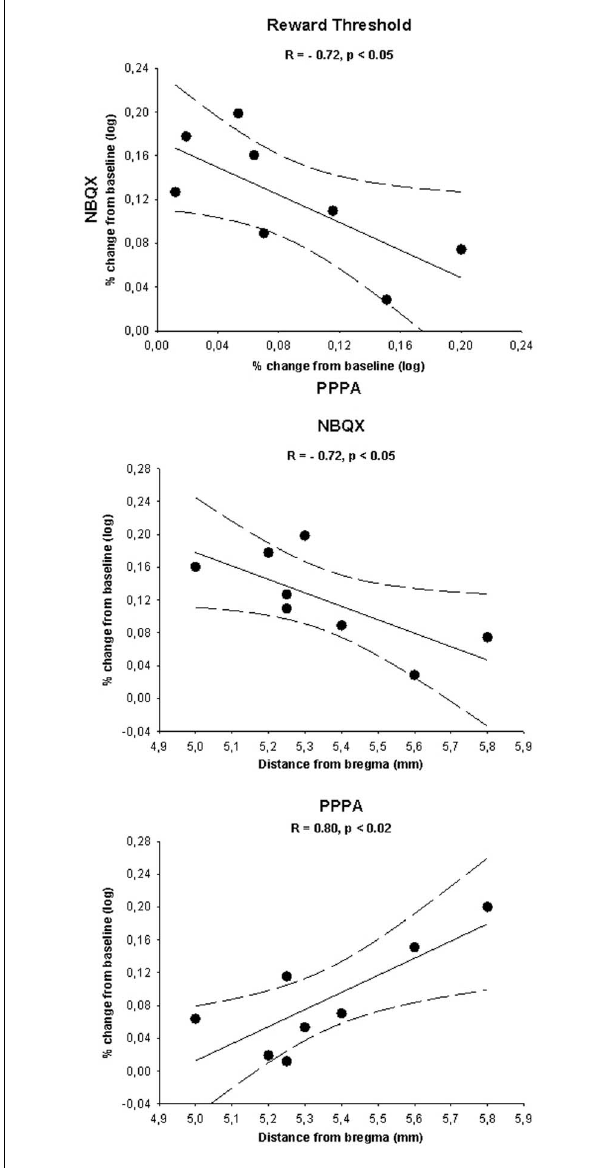
FIGURE 6 | The top panel shows a scatter plot illustrating the log percent change (from baseline) in reward threshold measured for each rat after injection of 0.825nmol of PPPA ( x -axis) and 800pmol of NBQX ( y -axis). Scatter plots illustrating the log percent change (from baseline) in reward threshold measured for each rat after injection of 0.825nmol of PPPA and 800pmol of NBQX as a function of the location of the injections sites along the antero-posterior axis of the brain are shown in the middle and bottom panels respectively. Correlation index (R) and level of significance are shown along with the linear regression line (plain line) and the 95% confidence interval (dotted lines) in each plot. See text for